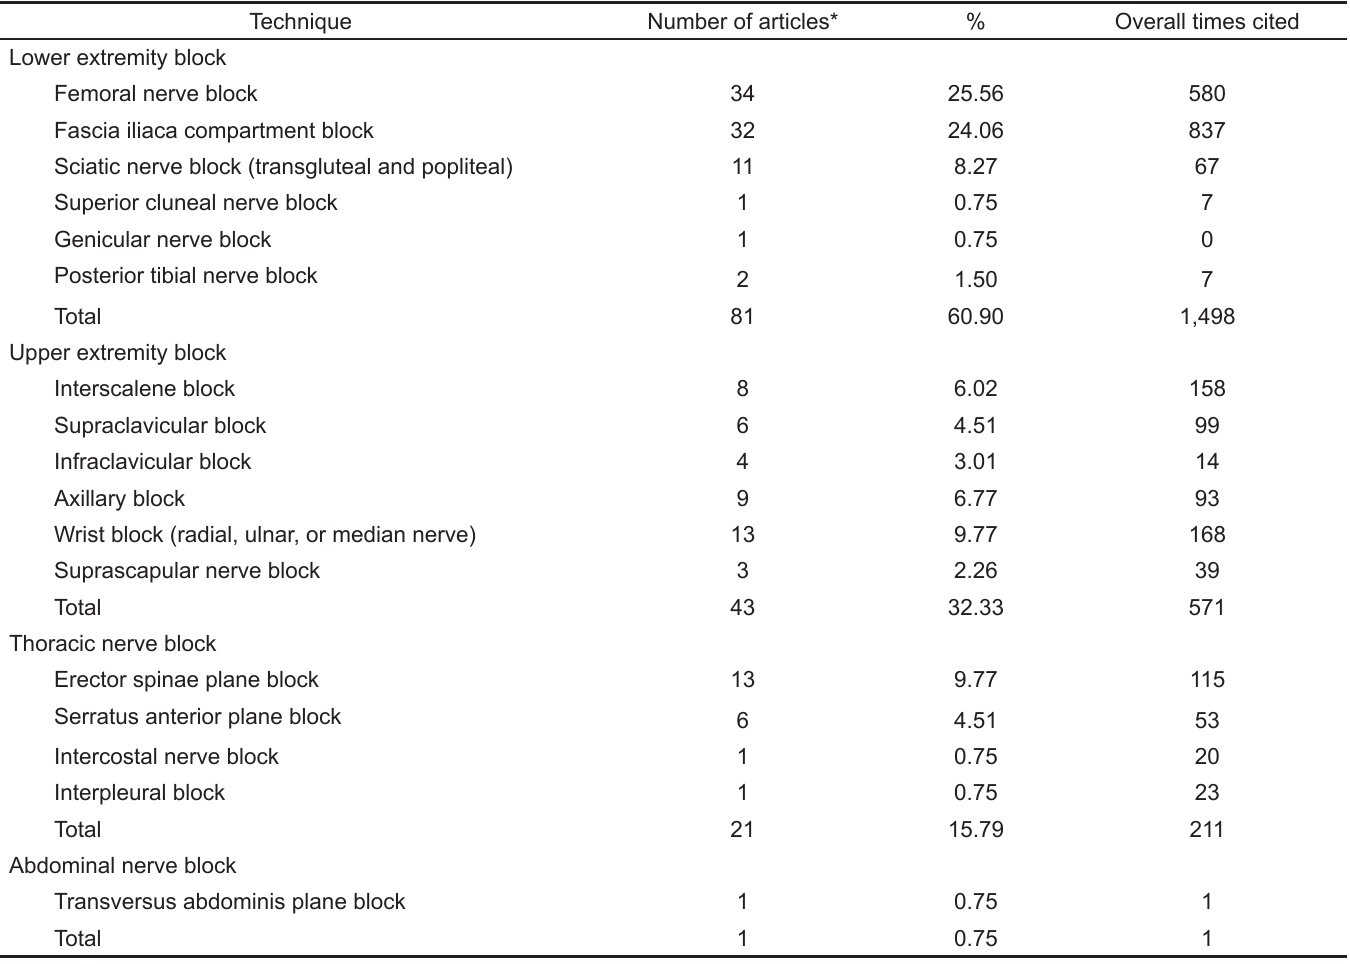
Table 3. Distribution of individual nerve block techniques reported in regional anesthesia-related articles.